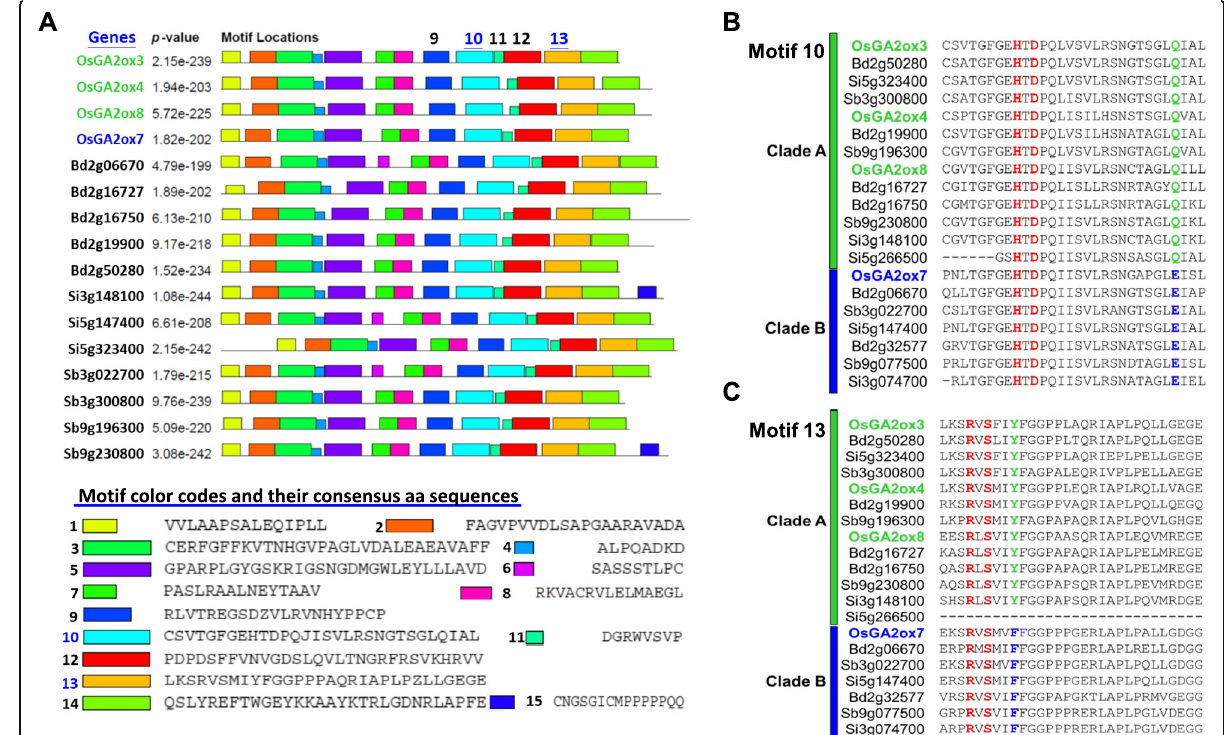
Fig. 6 Conserved protein motif identification among class I GA2oxs from Poaceae species and identification of distinguishable amino acids between clades A and B. a Conserved protein motif identification among 16 class I GA2oxs from Poaceae species by MEME algorithm analysis. The alignment of the 15 conserved motifs indicated by color codes and the consensus amino acid sequences of each conserved motif are shown. b Detailed consensus amino acid sequence alignment of motif 10, distinguished by Q in clade A and E in clade B. A putative iron-binding site (HTD) is shown in red. c Detailed consensus amino acid sequence alignment of motif 13, distinguished by Y in clade A and F in clade B. A putative 2-OG-binding site is shown in